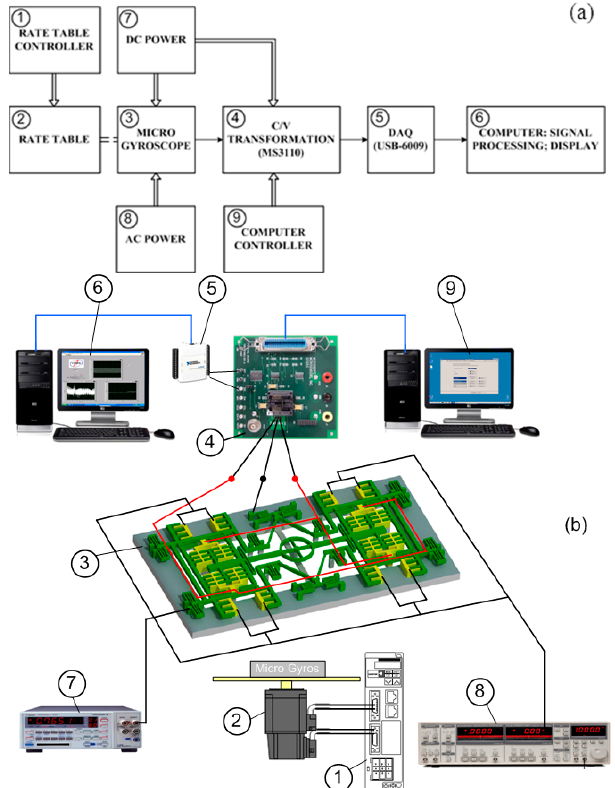
Figure 7. The measurement system is setup for characterizing TFG: ( a ) block diagram and ( b